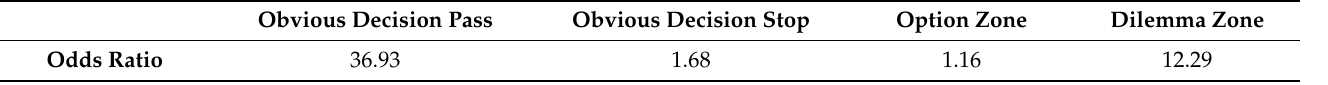
Figure 9. Distribution of decision probability depending on changes in acceleration and the relative position of vehicles (non-aggressive drivers). Table 10. Odds ratio for aggressive and non-aggressive drivers based on the relative position of